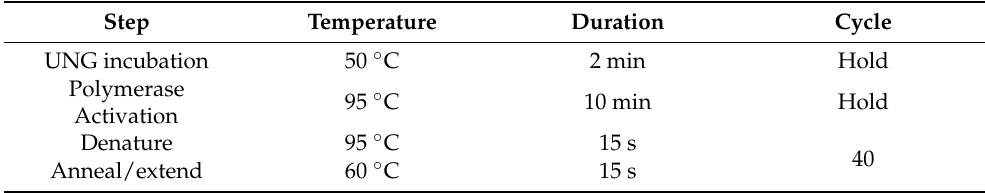
Table 5. qRT-PCR conditions TaqMan™ Gene Expression Master Mix.